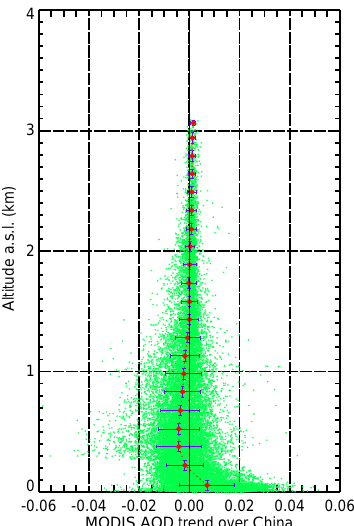
Figure 10. Vertical profiles of the trend in aerosol optical depth (AOD) from MODIS-Aqua in the winter seasons of 2002 to 2014 over the entirety of China. The “a.s.l” in the ordinate labels stands for “above sea